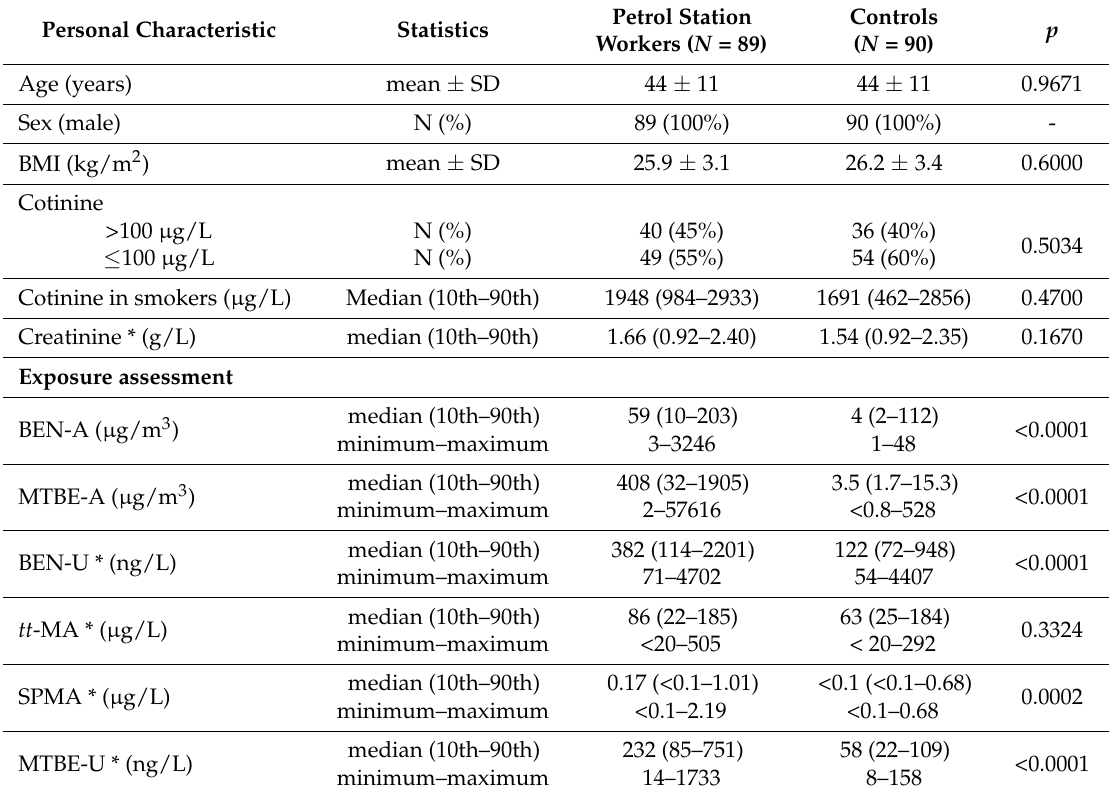
Table 1. Summary of general characteristics, markers of exposure and health status in petrol station workers and control